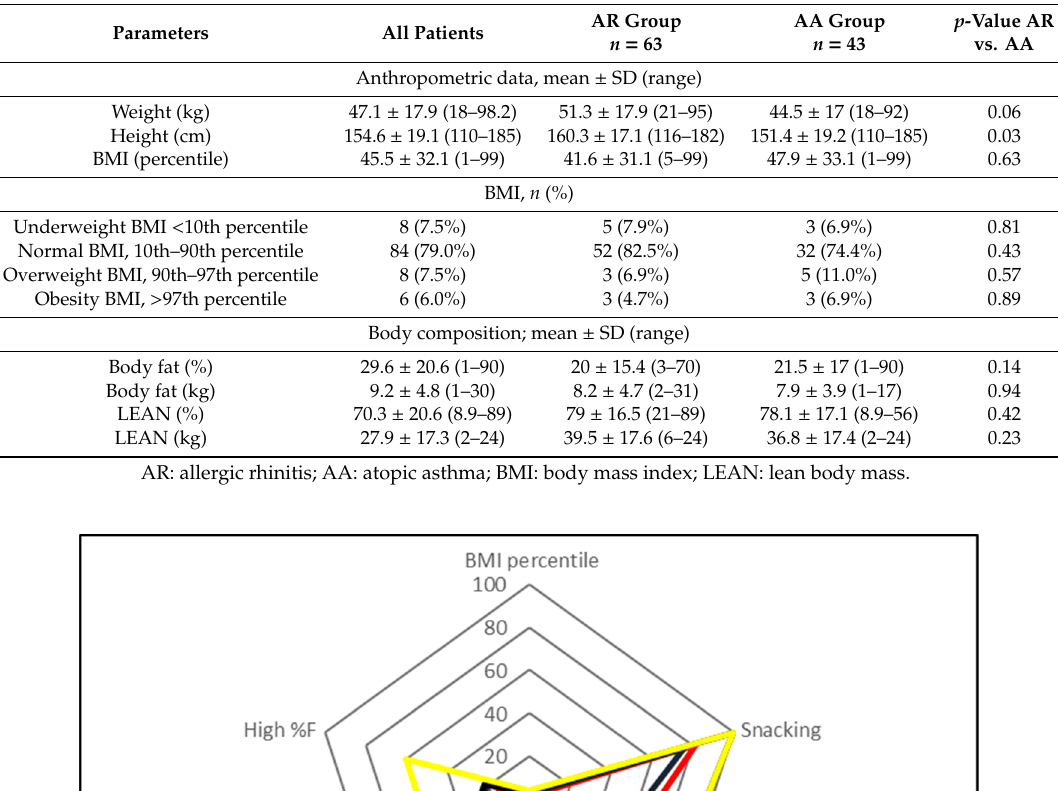
Table 3. Nutritional status and body composition in studied groups.